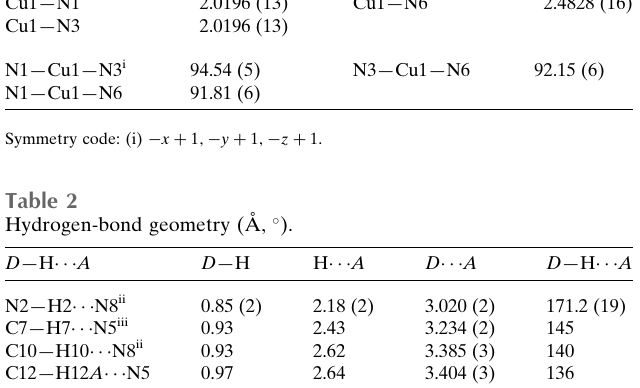
Table 1). The molecular geometry and atom-labelling scheme are represented in Fig. 1. The Cu II ion is located on an inversion centre. The bidentate dpa ligands occupy equatorial sites, with coordinating tcnoet ligands in the axial sites. The Cu—N6 bond length compares well with those reported for other Cu II complexes with axially coordinated tcnoet ligands (Thetiot et al. , 2003; Addala et al. , 2015).